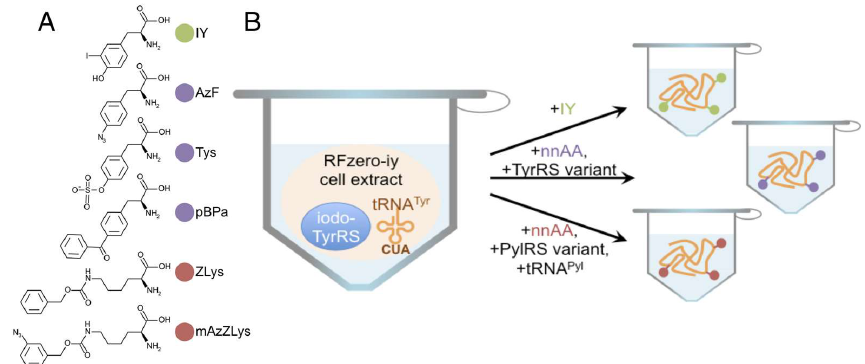
Figure 1. Incorporation of various non-natural amino acids by cell-free protein synthesis. ( A ) Structures of the non-natural amino acids used in this study. Colors indicate the types of non-natural amino acids shown in ( B ). ( B ) The concept of the RFzero-iy-based cell-free system for the incorporation of various non-natural amino acids, using a single type of cell extract. This strategy could be expanded to incorporate a variety of non-natural amino acids, by supplementing TyrRS variants, or tRNA Pyl and PylRS variant